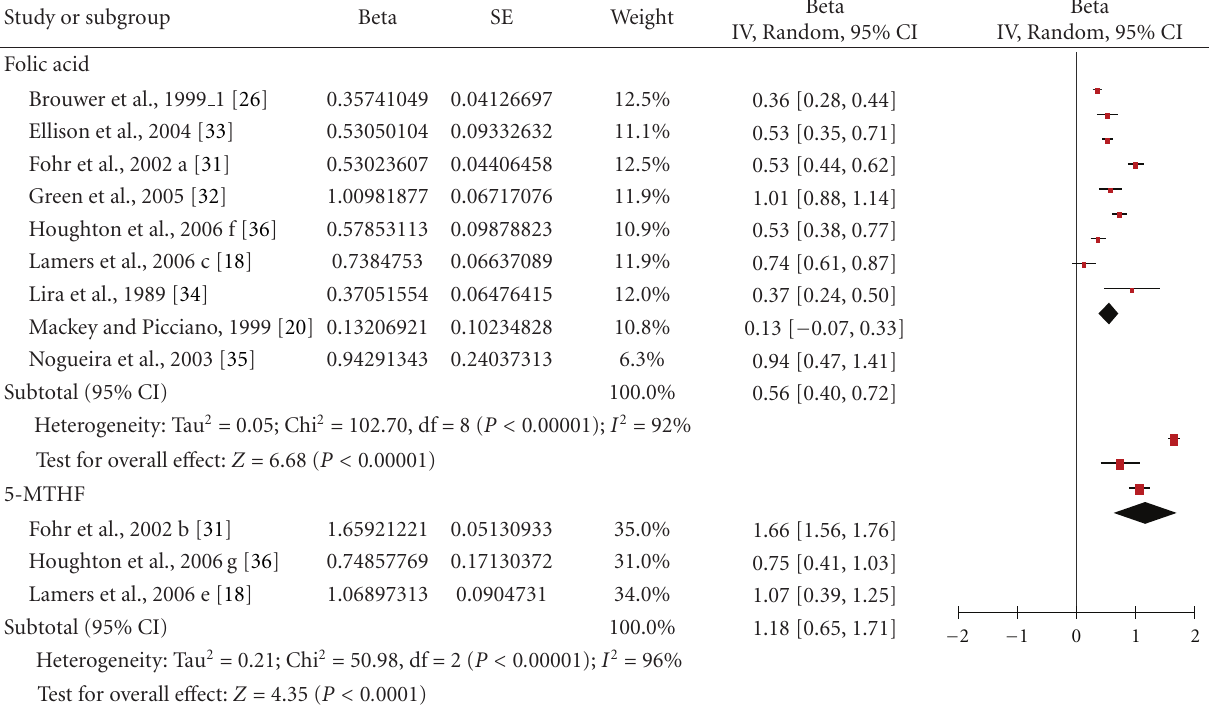
Table 4: Forest plot of the e ff ects of total folate supply (i.e., supplement p l us dietary folate), with the supplement provided in form of